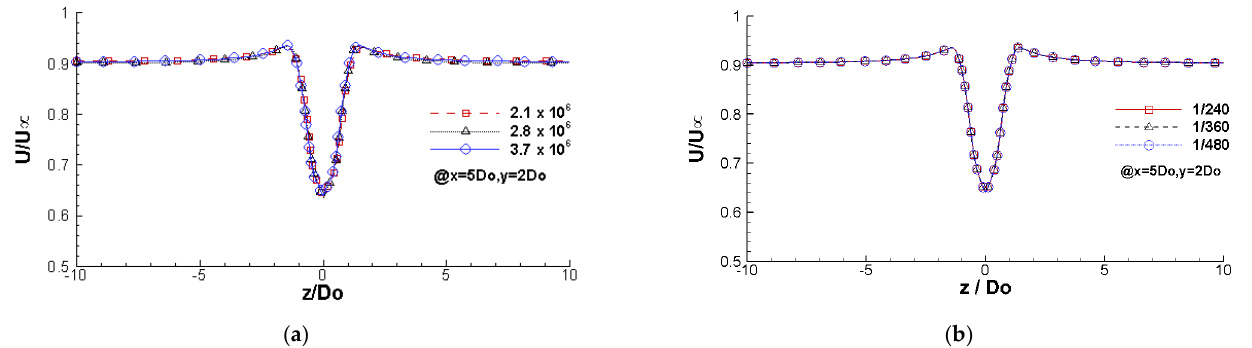
Figure 2. Comparison of the time-averaged velocity profiles along a spanwise, wall-parallel line (i.e., x / D o = 5 and y / D o = 2) within the boundary layer for the ( a ) mesh size (chosen value 2.8 × 10 6 ) ( b ) time step (chosen value 1/240) sensitivity studies for the twin SJs operating in